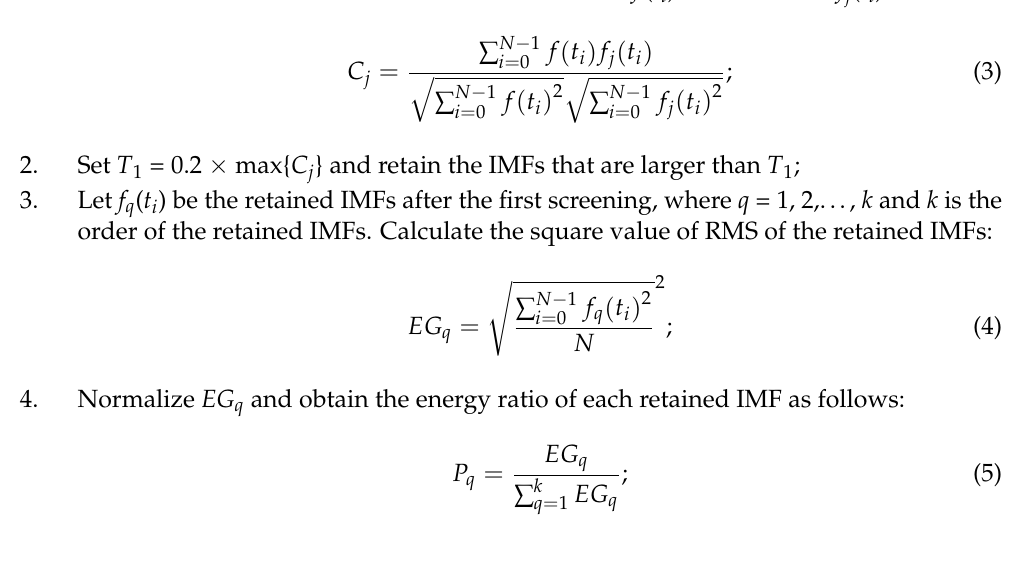
Figure 11. The local spectrum of gear-scuffing fault.